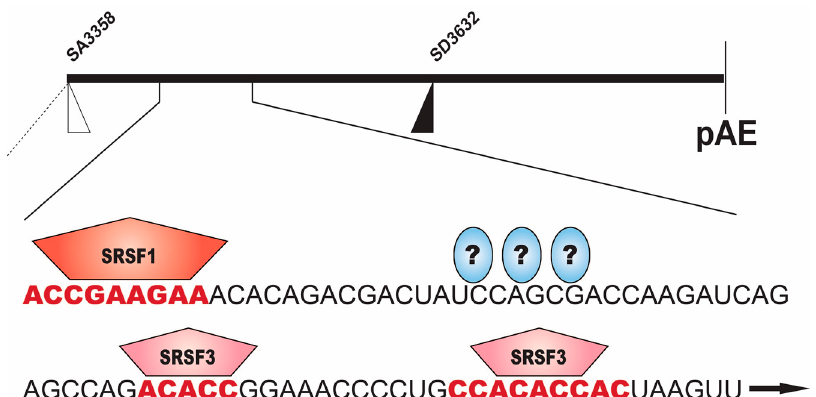
Figure 4. Schematic drawing of the middle region of the HPV16 genome ranging from the HPV16 3 ′ - splice site SA3358 to the early polyadenylation signal pAE. The suppressed HPV16 late 5 ′ -splice site SD3632 is indicated [41]. The blow up shows the splicing enhancer that is required for splicing to SA3358 [34–36]. Binding sites for the splicing factors serine/argine rich splicing factors 1 and 3 (SRSF1 and SRSF3) are indicated in red [6,7,9,35–37]. Question marks indicate unidentified cellular